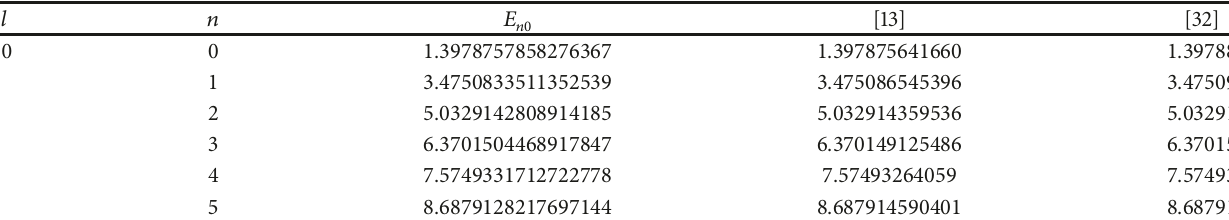
Table 1: Comparison of eigenvalues of 𝑉(𝑟) = −1/𝑟 + 𝑟 for 𝑛 states.